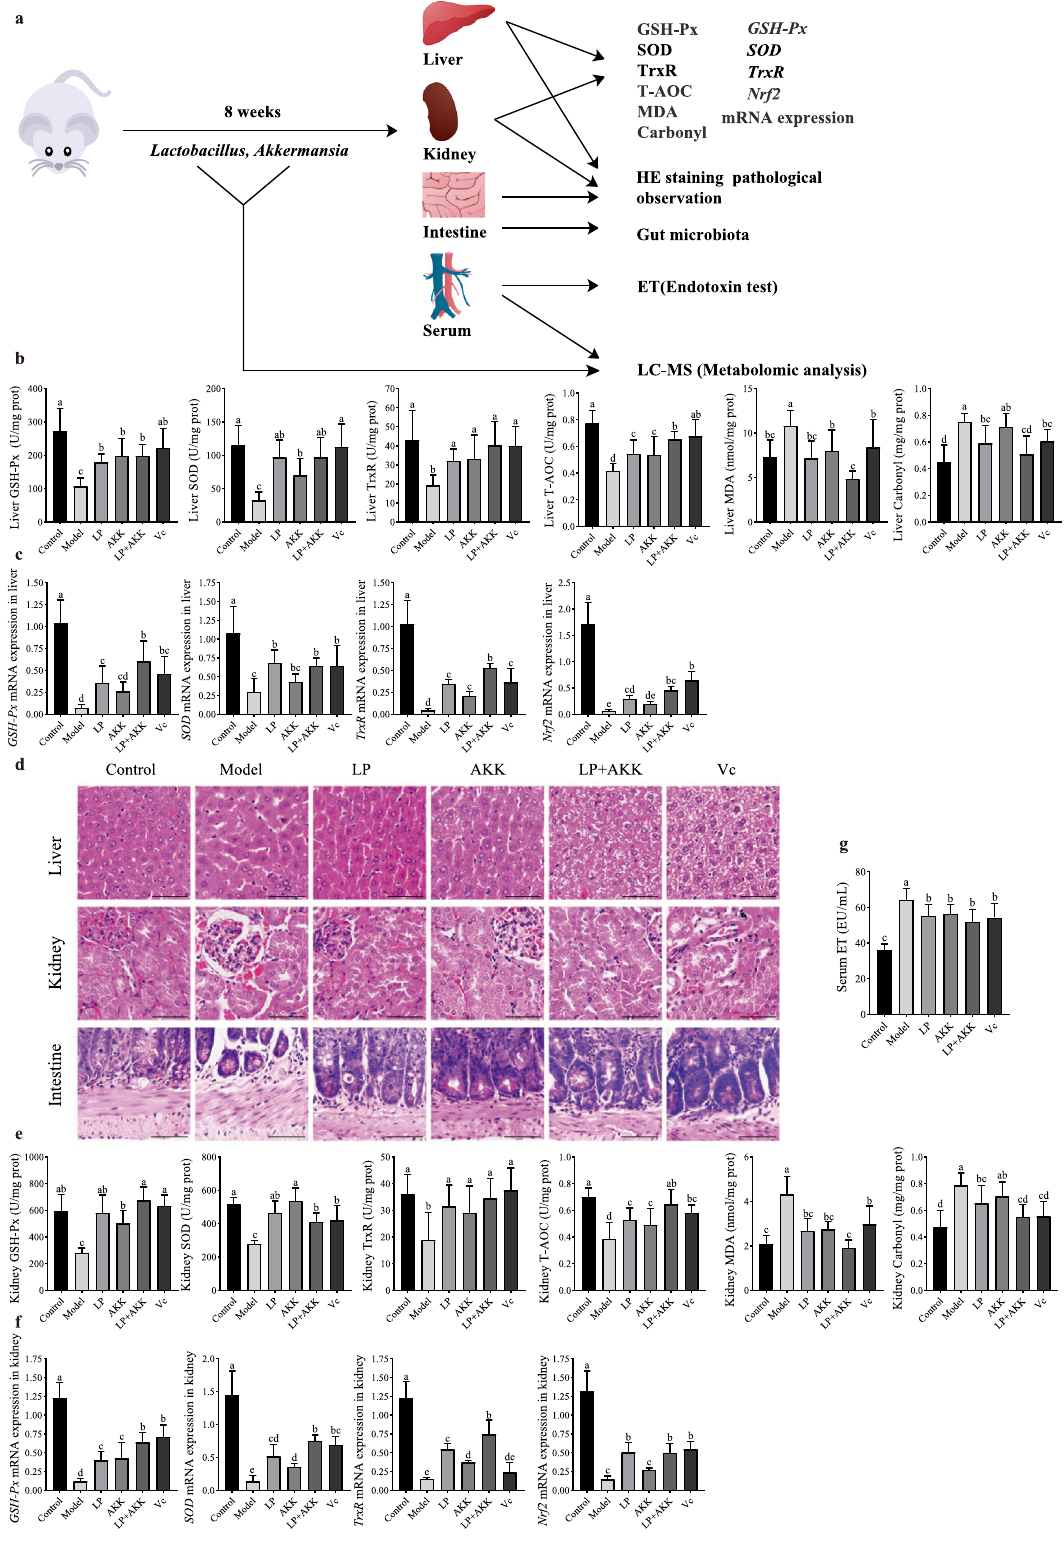
and stored for further analyses. Blood pressure (mm Hg) was measured three times using an automatic manometer, and the mean of the measures was used in the analysis. Statistics of the factors are summarized in Table 1, Table S1, and Fig.